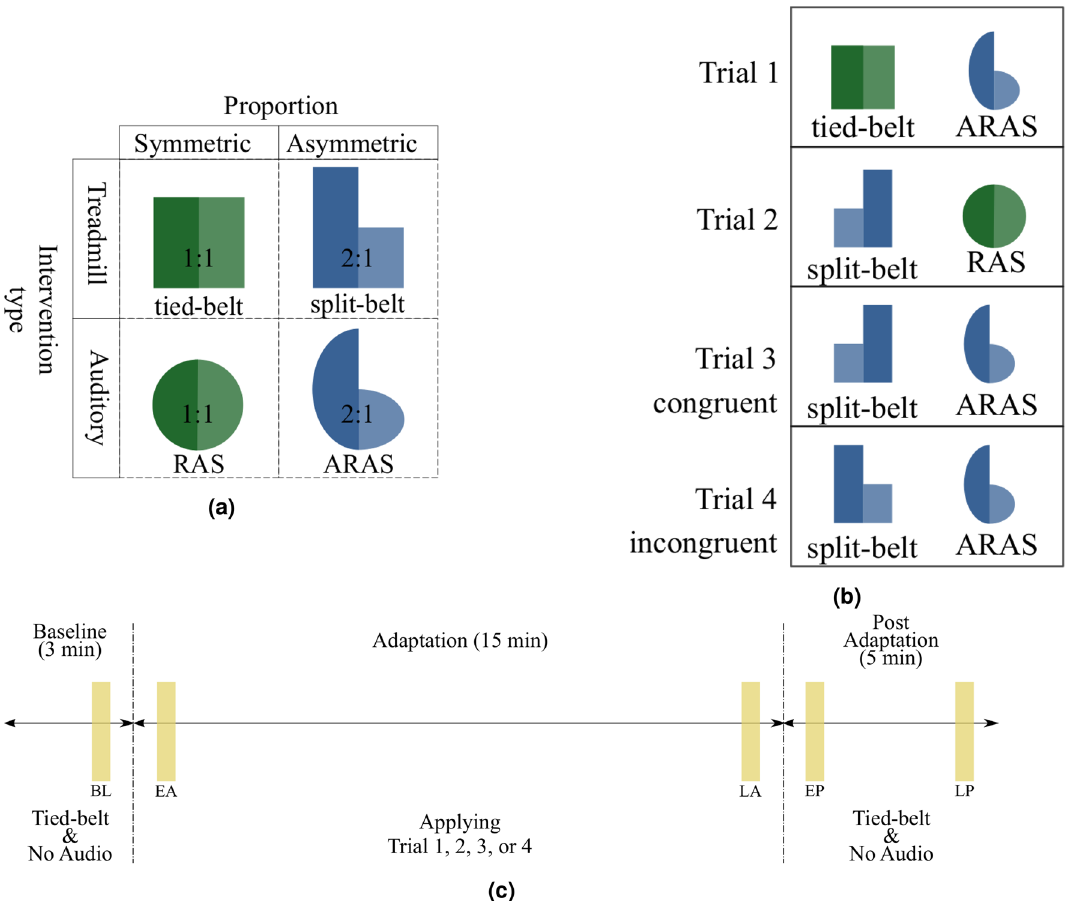
Figure 2. Experimental design: ( a ) Types of therapeutic interventions where height of each shape represents relative magnitude of intervention. ( b ) Therapy interventions that were applied in each trial. Trial 3 and 4 both used two asymmetric 2:1 (blue) therapy interventions. In order to test the effect of the error augmentation mechanism, SBT and ARAS were once applied congruently (trial 3) and once incongruently (trial 4). ( c ) Timeline: duration of each section in the experiments. Yellow rectangular shapes show the approximate location of time windows used for analysis. Each window includes 25 left and 25 right steps. The time windows are located after the first 10 steps or before the last 10 steps of each phase. BL baseline, EA early adaptation, LA late adaptation, EP early post-adaptation, LP late